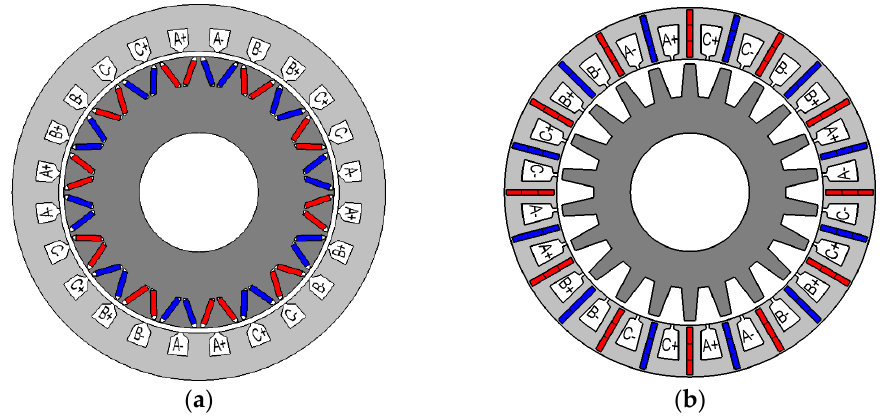
Figure 1. Sketch of the machine geometry: ( a ) interior permanent magnet synchronous generator (IPMSG); ( b ) permanent magnet flux-switching generator (PMFSG).